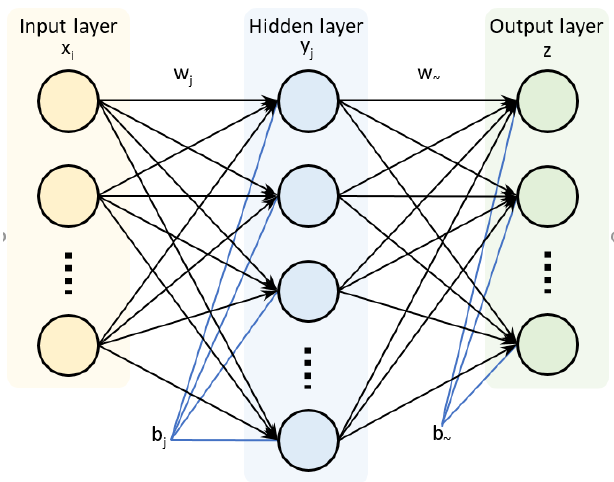
Figure 2. A multilayer perceptron (MLP) network.